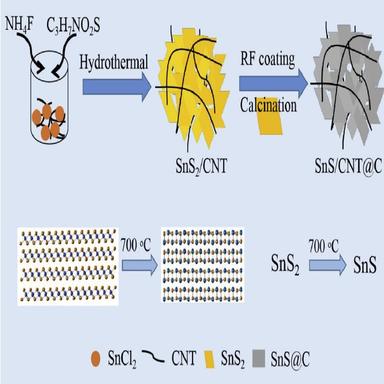
Schematic representation of fabrication of SnS/CNT@C composite; Schematic diagram illustrating the phase transition process between SnS2 and SnS under annealing process.